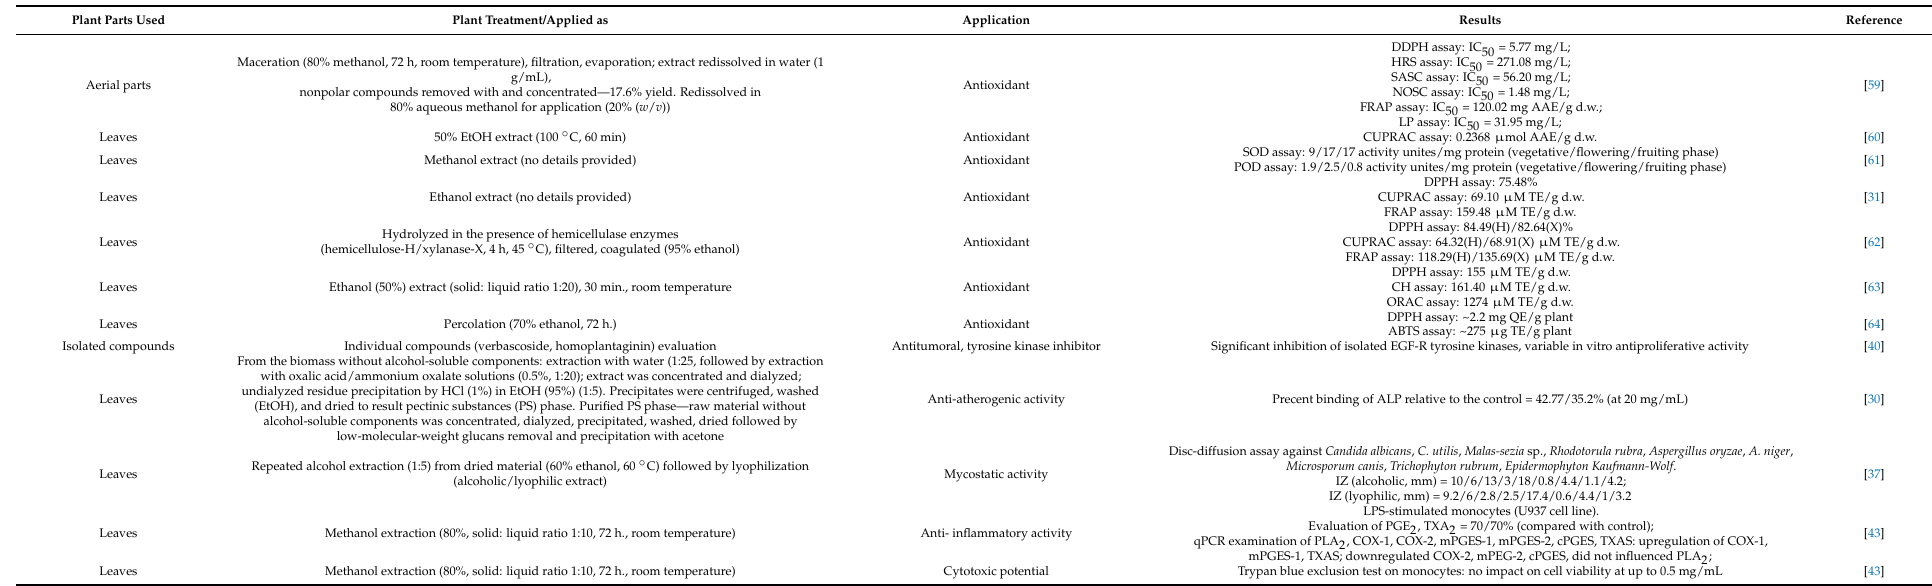
Table 2. Biomedical properties of Plantago media